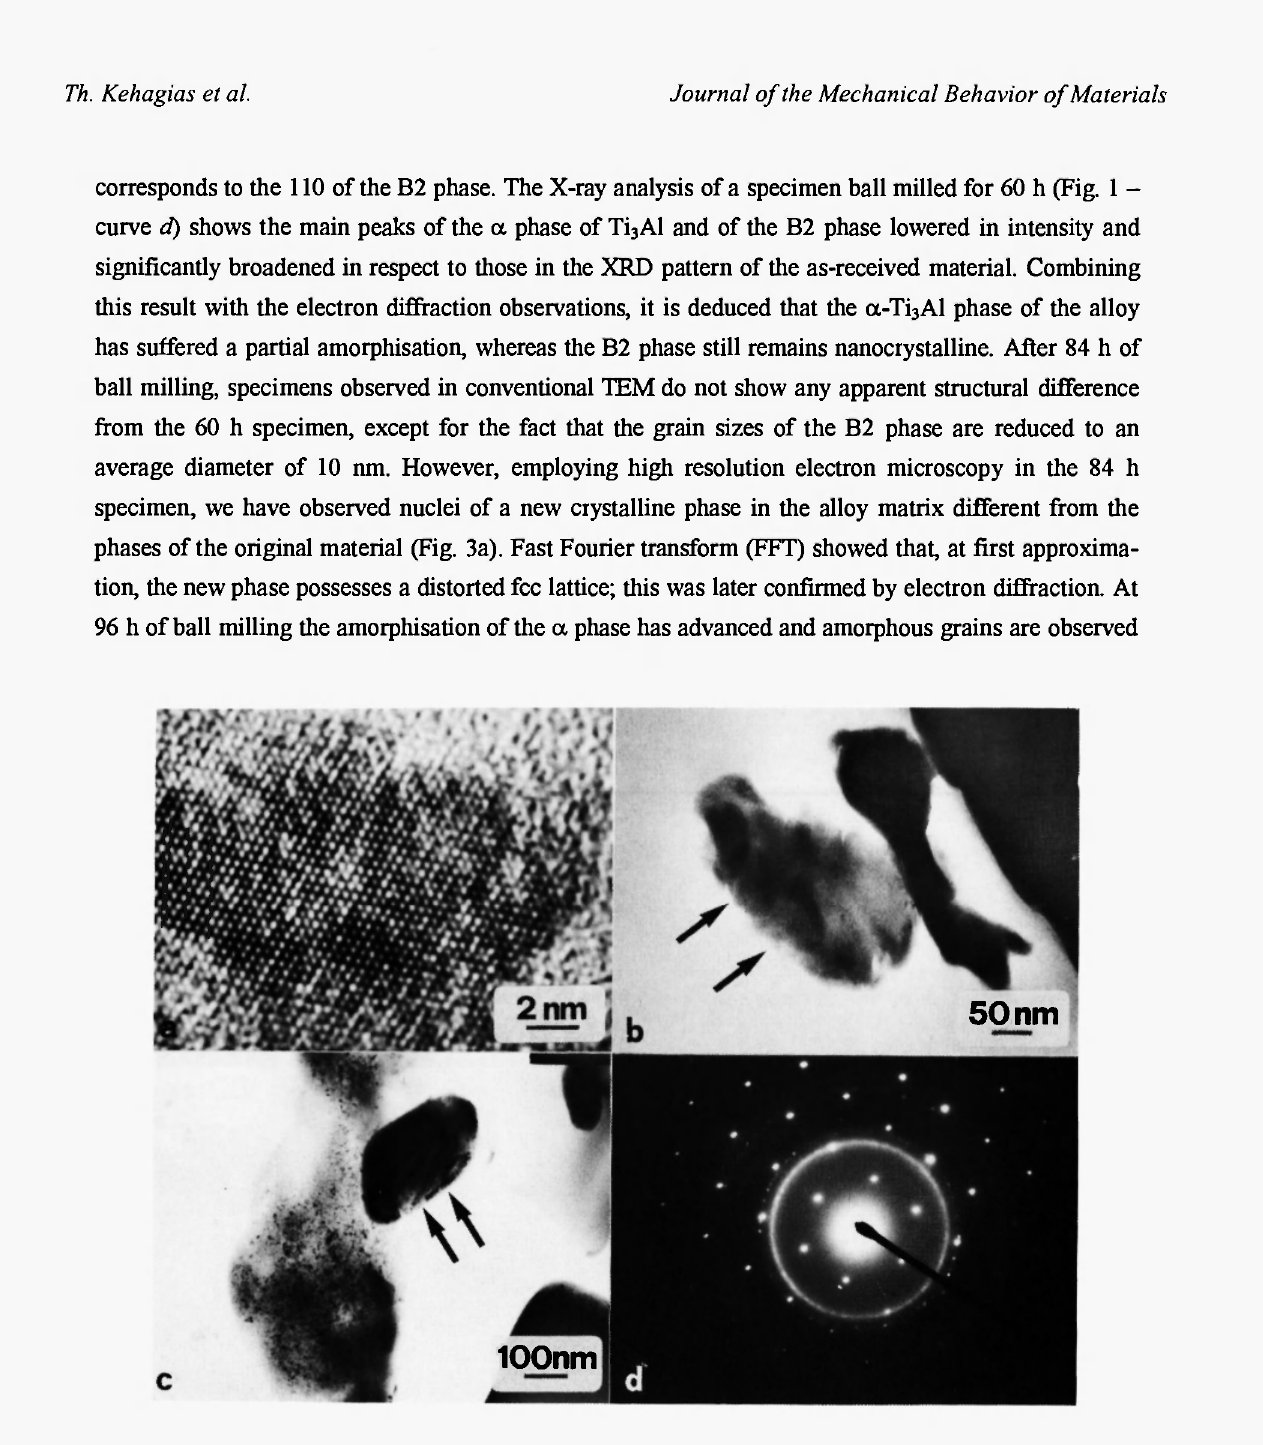
Fig. 3: a) HREM micrograph revealing the growth of a nucleus of new material at the 84 h ball milled specimen, b) An amorphous a-Ti Al grain (indicated by arrows) is observed together with a 3 nanocrystalline Ti AlNb grain, at 96 h of ball milling, c) The nuclei of Fig. 3 a have grown into 2 microparticles (indicated by arrows) after 102 h of ball milling, d) Corresponding diffraction pattern of Fig. 3c showing the coexistence of the nanociystalline Ti AlNb phase with the 2 single crystalline form of the new